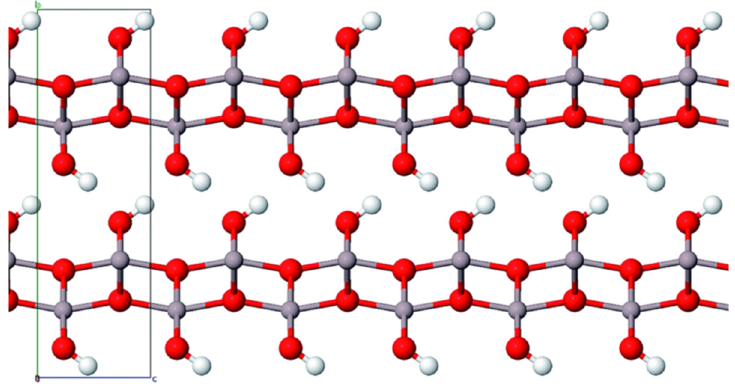
Figure 2. Structure of boehmite. Grey, red, and white spheres represent Al, O, and H atoms, respectively. Atoms enclosed inside rectangle represent the bulk unit cell. Reproduced from Ref. [14] with permission from the Royal Society of Chemistry.